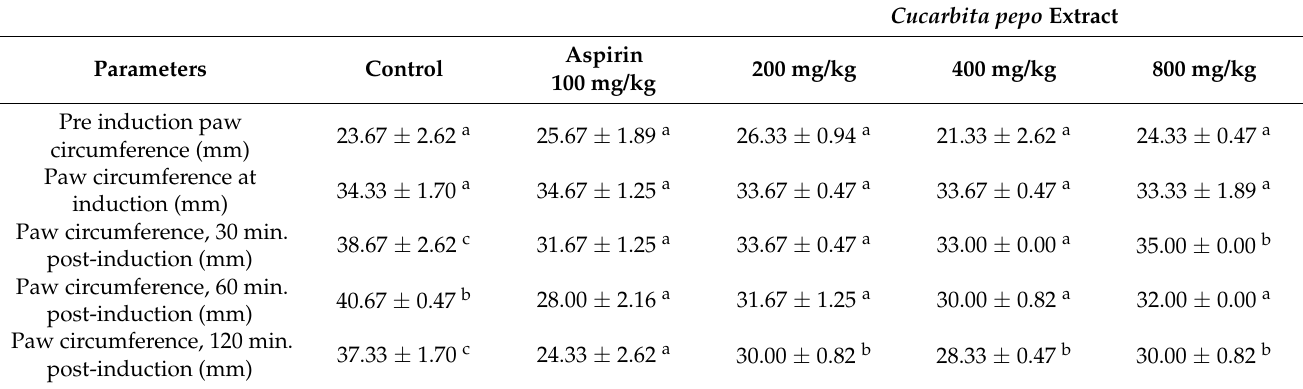
Table 7. Effects of paw treatments on paw